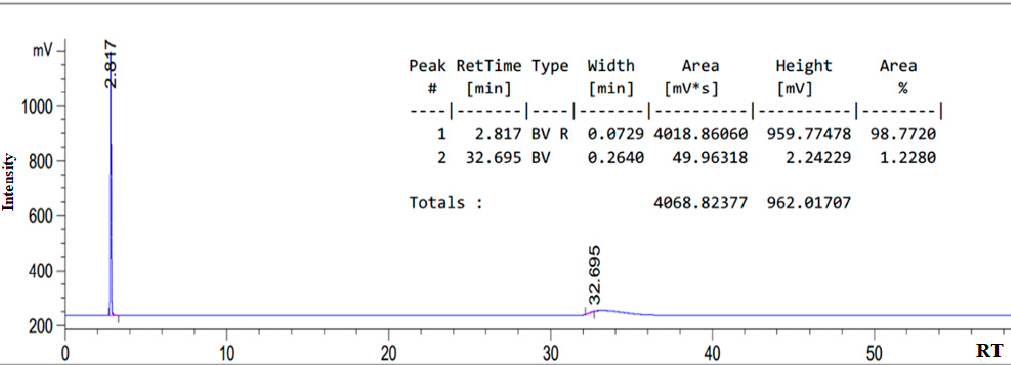
Figure A3. HPLC chromatogram for 0.5wt.% Sodium Oleate. Processes 2020 , 8 , x FOR PEER REVIEW